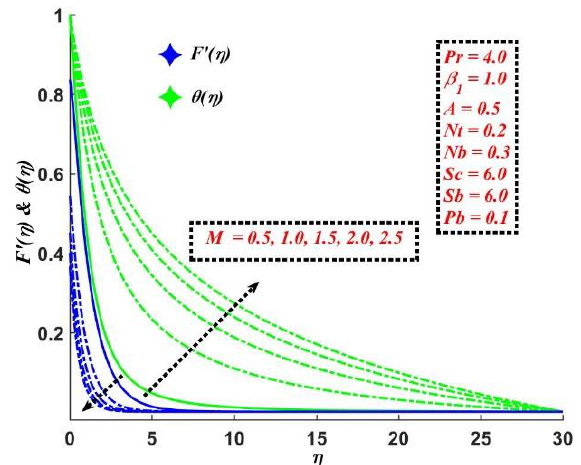
Figure 3. Influence of the curvature parameter on 𝜙(𝜂) and 𝜒(𝜂) .